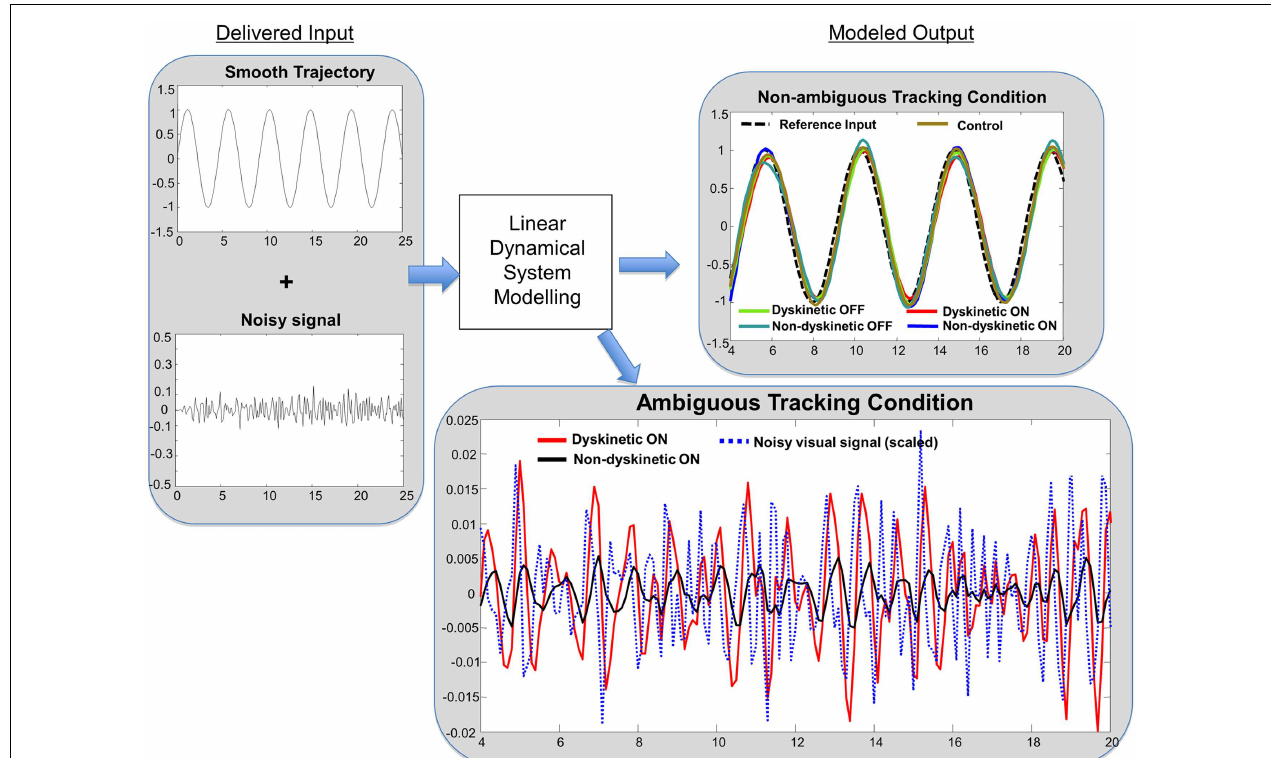
shown.The subjects’ output in non-ambiguous conditions is similar across groups. In the lower box, the effect of “noisy” ambiguous input on modeled output of a dyskinetic and a non-dyskinetic subject is shown.The increased decay rate of dyskinetic subjects on medication leads them to attempt to track the noise more significantly.The noisy visual signal is reduced to 15% of the actual magnitude for visualization